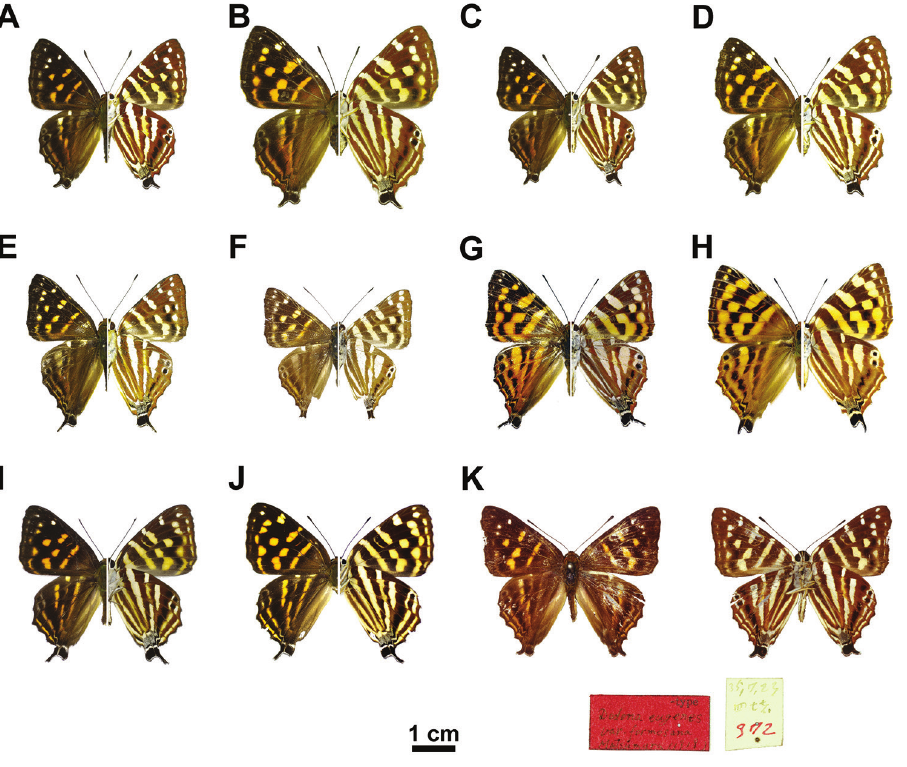
Figure 5. Pinned specimens of Dodona formosana and their relatives. A D. formosana (spp. formosana ) ♂ B D. formosana (spp. formosana ) ♀ C D. formosana (spp. esakii ) ♂ D D. formosana (spp. esakii ) ♀ E D. eu. eugenes ♂ F D. eu. venox ♂ G D. egeon ♂ H D. egeon ♀ I D. maculosa ♂ J D. maculosa ♀ K type of D. for- mosana